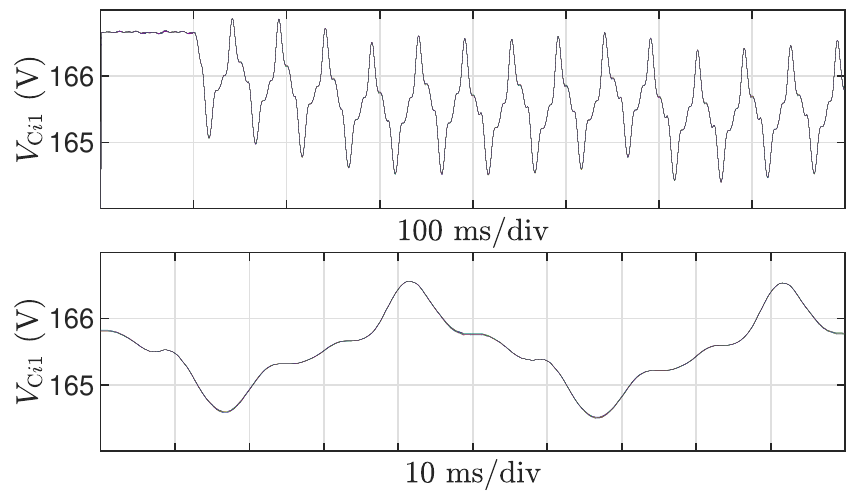
Figure 12. NLC VBA performance: ( Top ) zoom–out depicting transients at initial conditions; ( Bottom ) zoom–in at